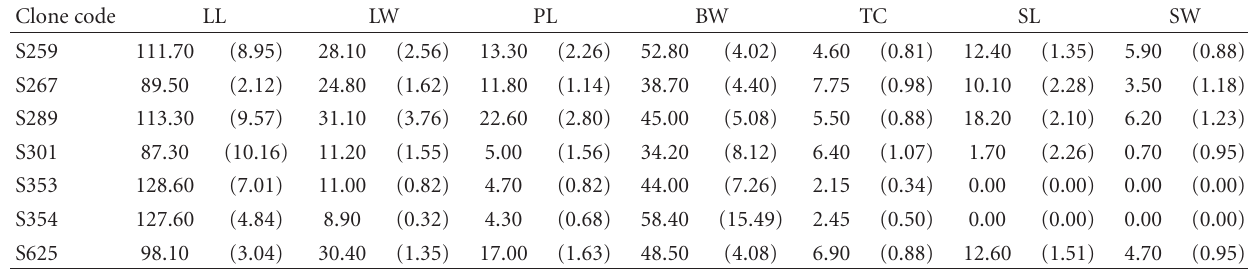
Table 2: Means and standard deviations (in parentheses) of seven morphological characters studied in Salix clones selected for biomass production (LL: leaf length, LW: leaf width, PL: petiole length, BW: distance from leaf base to leaf widest point, TC: teeth per cm, SL: stipule length, and SW: stipule